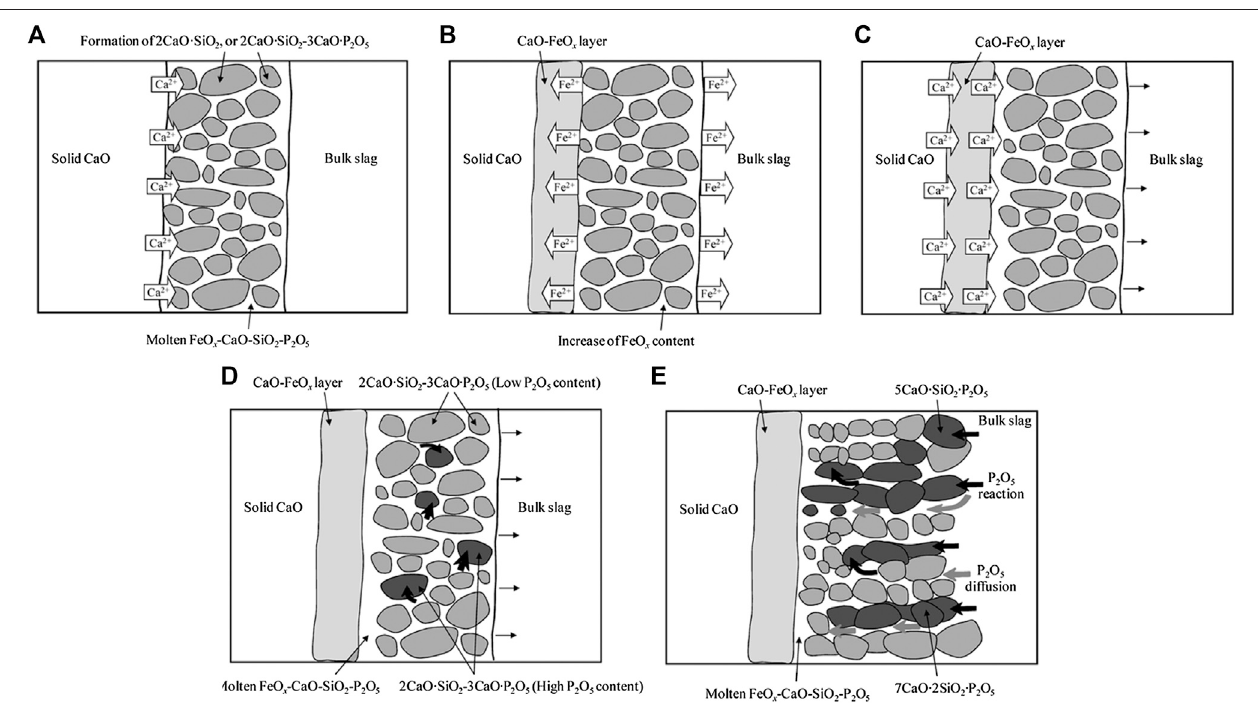
FIGURE 2 | Reaction mechanism of solid CaO and CaO-SiO 2 -FeO-P 2 O 5 slag (Saito et al., 2009). [Figure 10 of (Saito et al., 2009), Copyright The Iron and Steel Institute of Japan].